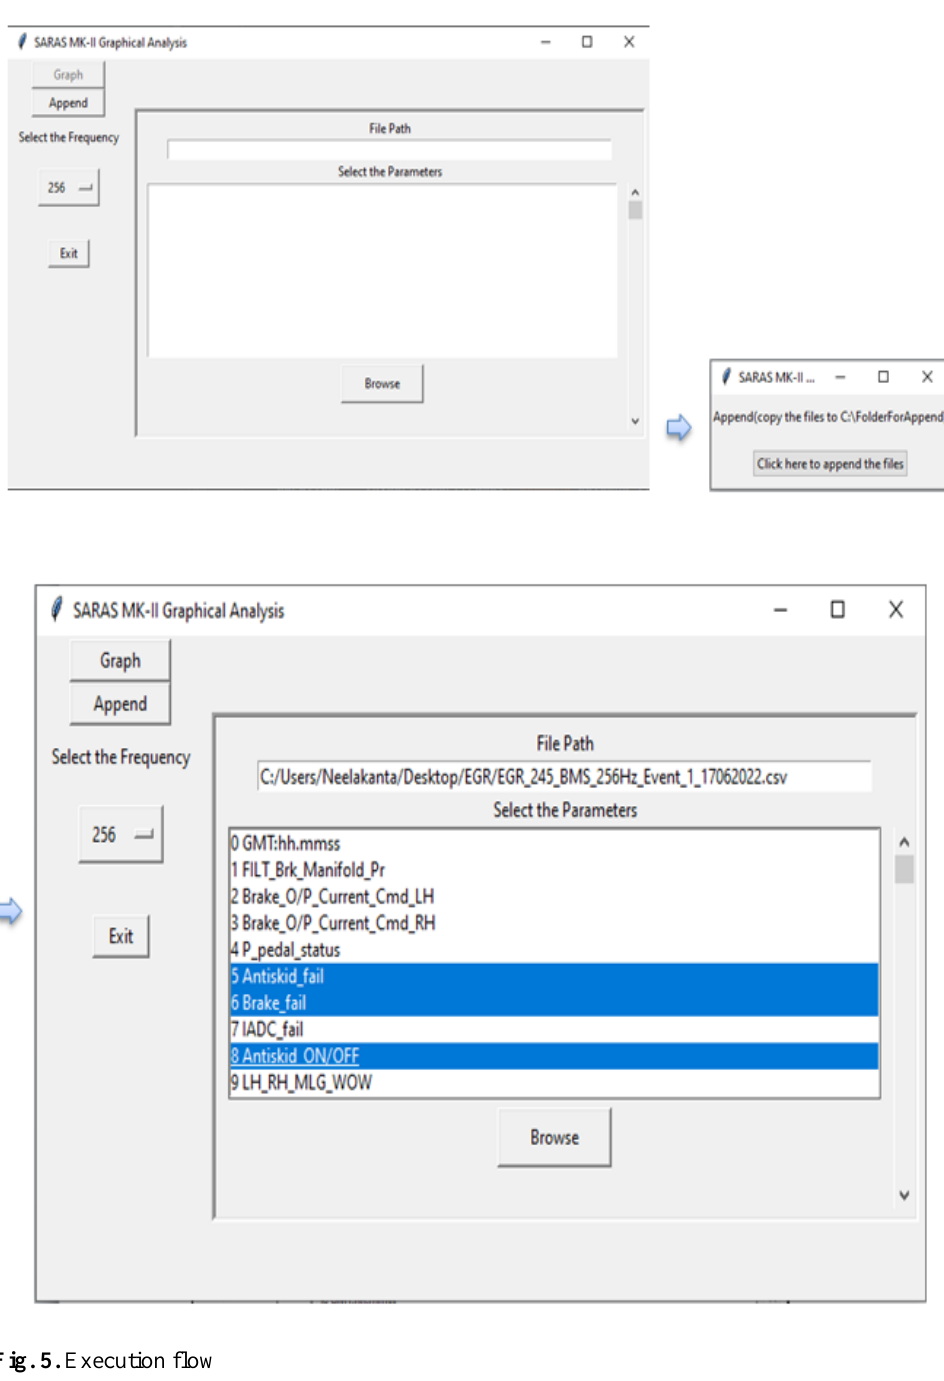
Fig. 5. Execution